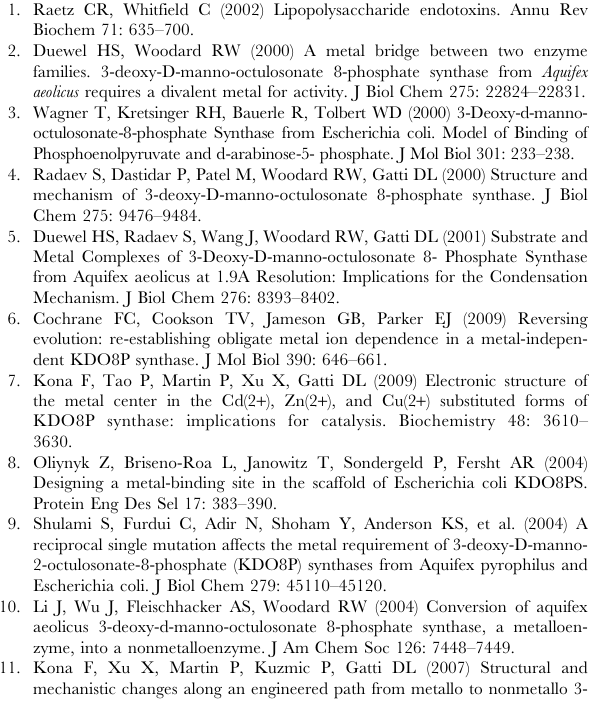
Table S5 Correlation coefficients between the vectors of MI scores (based on a MSA of 145 sequences) for i,j pairs above a threshold s value and the vectors representing the average effect of those pairs on the stability of B1 type metallo b -lactamases. (DOC) PDB S1 Atomic coordinates in pdb format for the structure of Nm. KDO8PS which, based on a clustering procedure, is the most representative conformer of all the states sampled during the 6– 12 ns part of the MD run shown in Figure S1. (PDB) PDB S2 Atomic coordinates in pdb format for the structure of Nm. KDO8PS which, based on a clustering procedure, is the 2 nd most representative conformer of all the states sampled during the 6–12 ns part of the MD run shown in Figure S1. (PDB) PDB S3 Atomic coordinates in pdb format for the structure of Nm. KDO8PS which, based on a clustering procedure, is the 3 rd most representative conformer of all the states sampled during the 6–12 ns part of the MD run shown in Figure S1. (PDB) Energy Matrix S1 FoldX energy matrix. The rows (1–280, top to bottom) of the matrix correspond to the amino acid sequence of Nm. KDO8PS. The columns (1–20, left to right) of the matrix correspond to the 20 common amino acids in the following order: